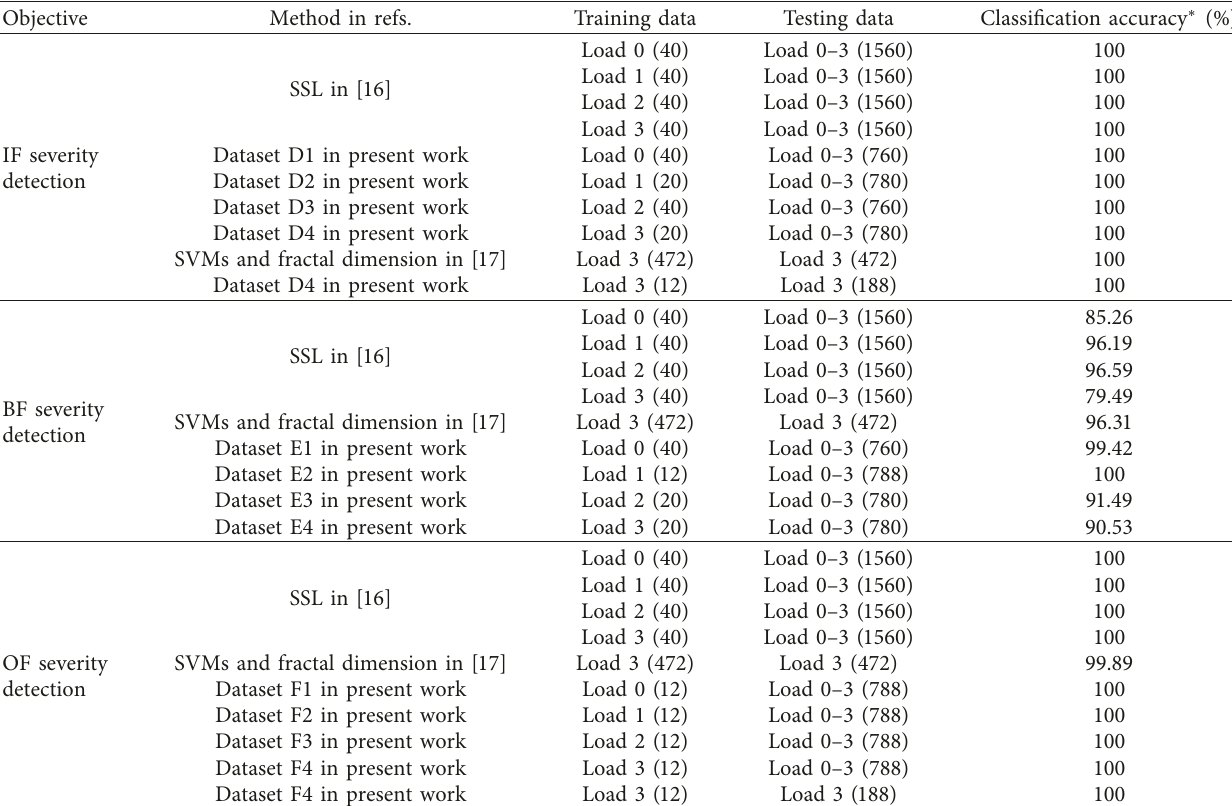
Table 9: Comparisons for single-fault severity detection between current work and some published work. Objective